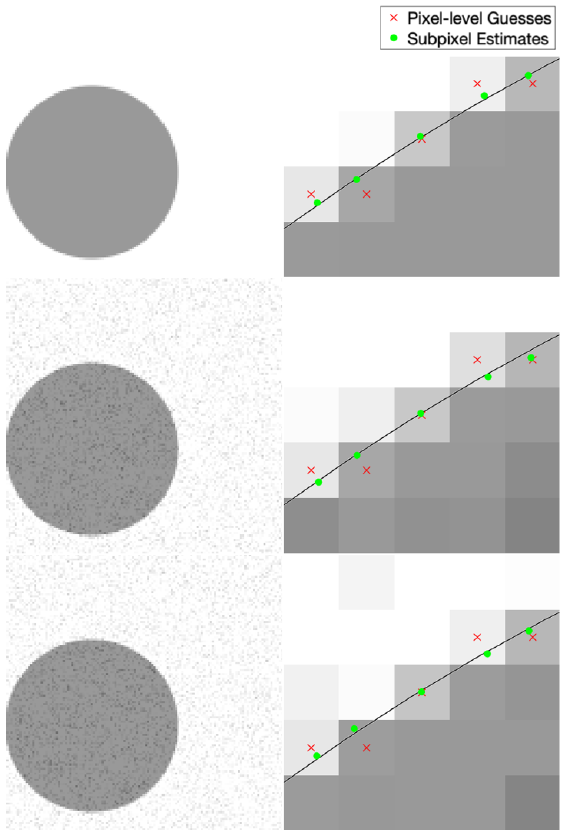
Figure 6. Qualitative visualization of subpixel edge localization performance at varying levels of blur and SNR. The left column shows the full synthetically generated image and the right column shows a small area within that image. The rows represent different noise and blur levels (top: no noise or blur; middle: noise only (approximately 28.4 peak signal to noise ratio); bottom: noise and blur (2D Gaussian kernel with standard deviation 0.3 pixels)). The black line is the exact location of the true